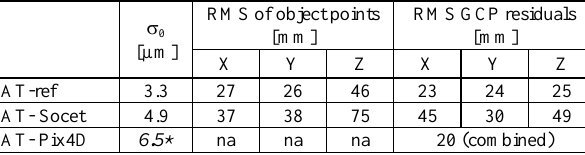
Figure 5: Height difference map between Swinglet Pix4D and LiDAR DTM. On smooth and flat areas, the differences do not exceed +/- 15 cm. As soon as terrain discontinuity appears, the difference increases because the image matching tends to smooth obstacle (buildings, walls, cars). The road below the bridge illustrates this phenomenon (circle). The vegetation areas show also large discrepancies. It is normal since the photogrammetric measurements can not get information below canopy while LiDAR provides it.